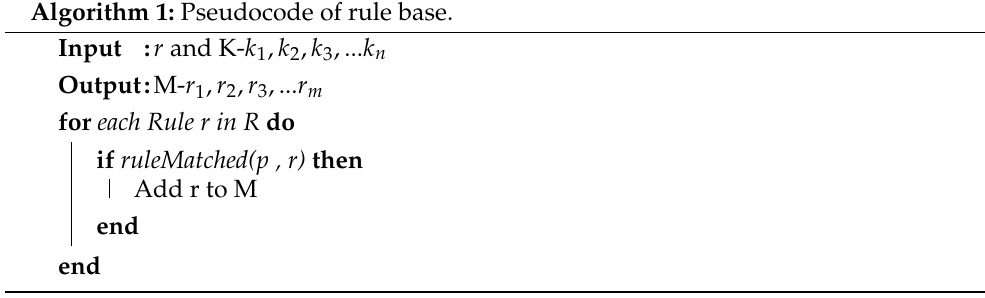
Figure 3. An example rule. Algorithm 1: Pseudocode of rule base.